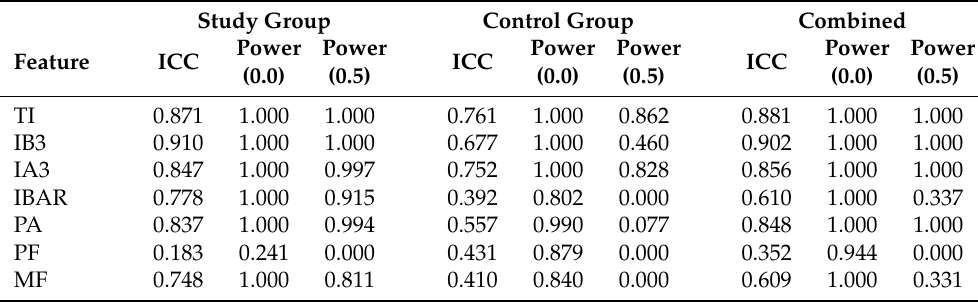
Table A1. Post hoc power analysis of the ICC for each feature in Table 1. The columns of power (0.0) and power (0.5) correspond to power values obtained for the null hypothesis of ICC equal to 0.0 and 0.5,